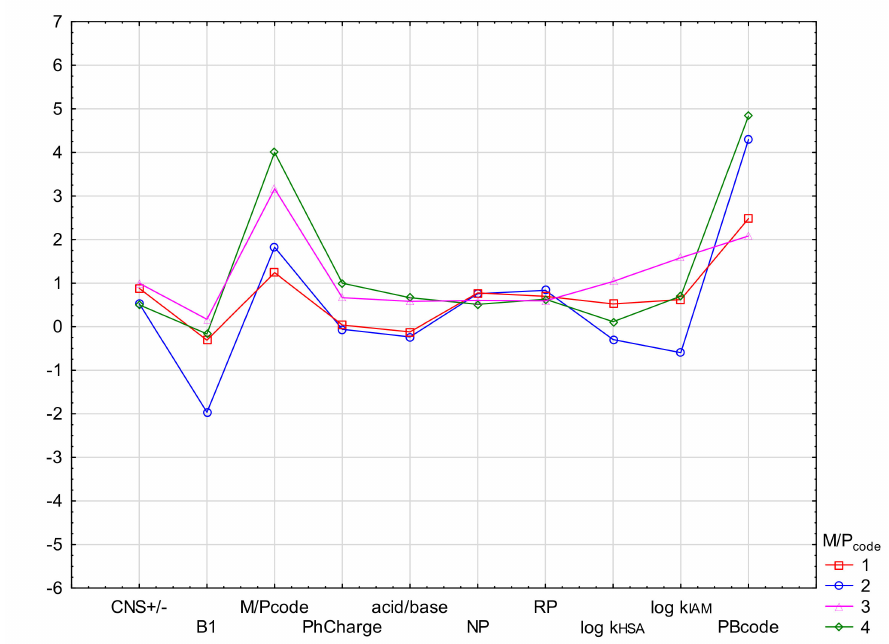
Figure 4. Mean descriptor values in M/P code cluster analysis (k-means method) using biological and chromatographic descriptors.